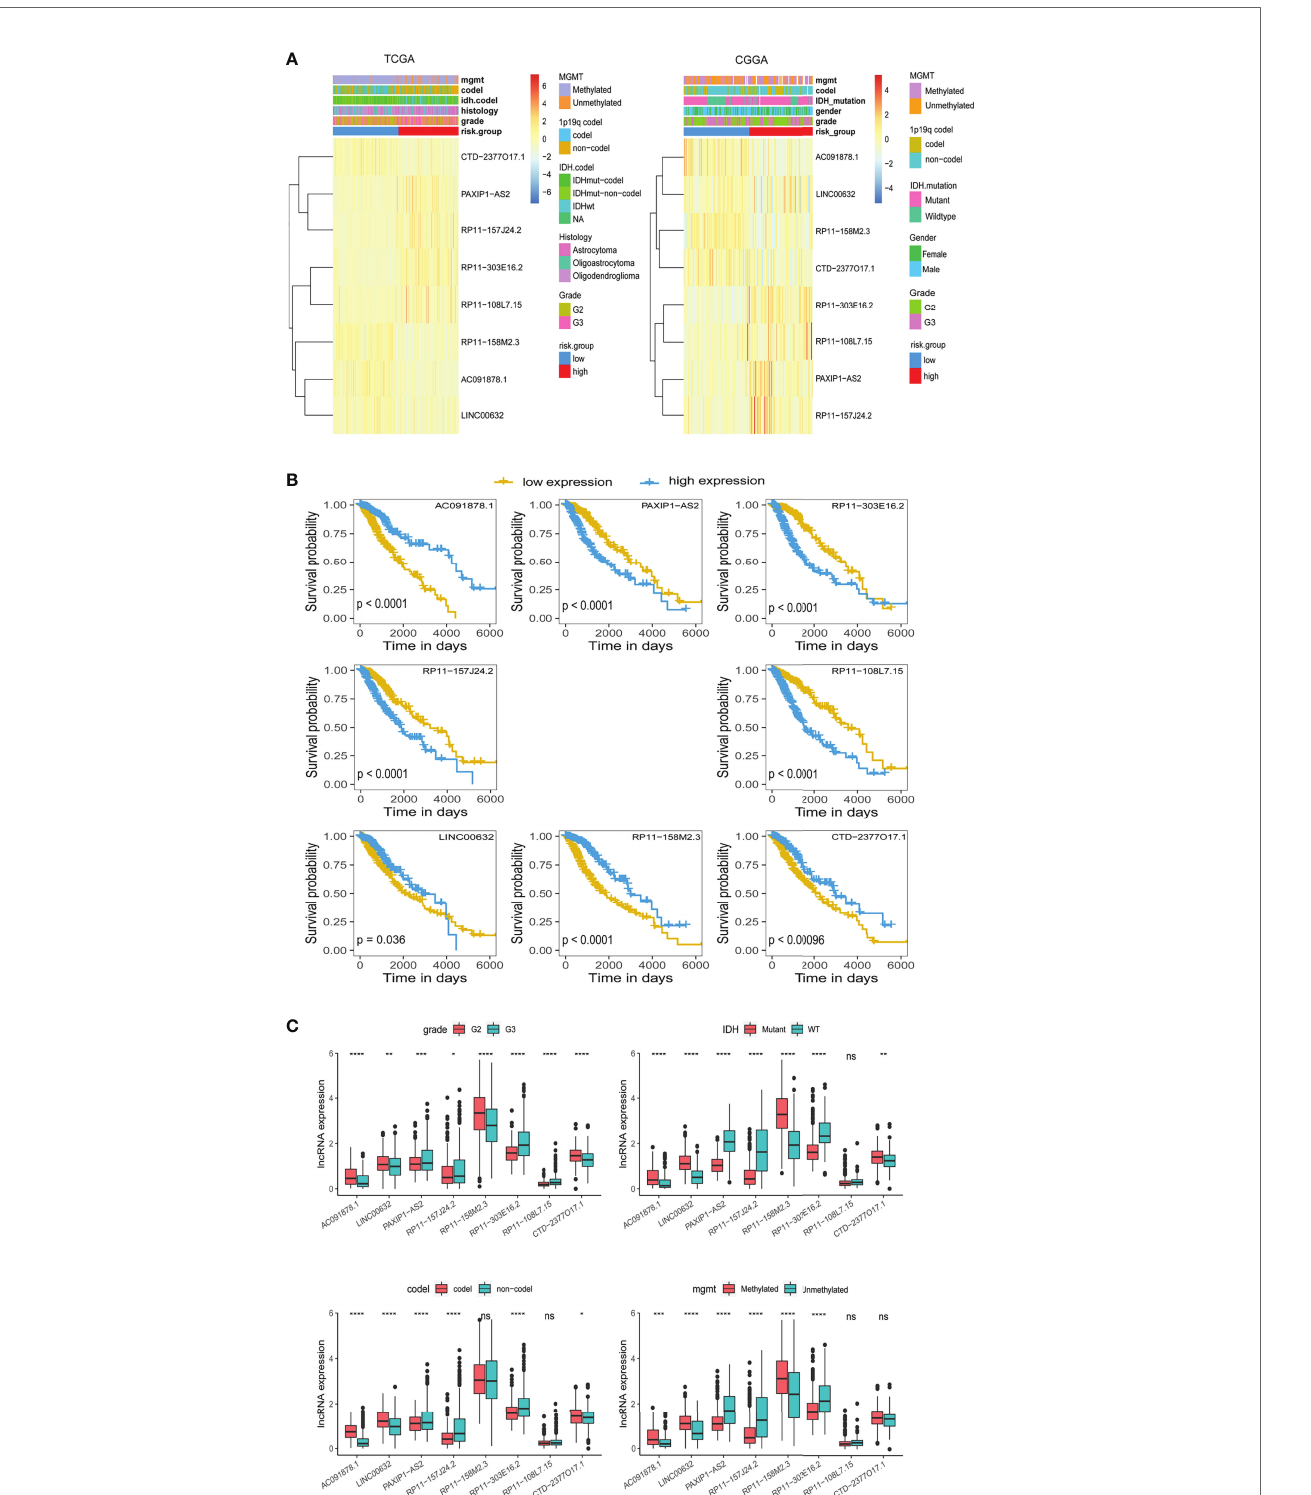
FIGURE 3 | Differential expression of lncRNAs constituting the m5C LPS. (A) Heatmaps showing m5C-related lncRNAs expression and clinicopathological features in the TCGA and CGGA datasets. (B) Kaplan-Meier curves showing the overall survival of patients grouped by expression of each m5C-related lncRNA in the TCGA dataset. (C) Differential expression of the eight m5C-related lncRNAs in WHO grade, IDH, 1p/19q codeletion, and MGMT promoter methylation subgroups. *p<0.5, **p<0.01, ***p<0.001, ****p<0.0001, ns, no signi fi